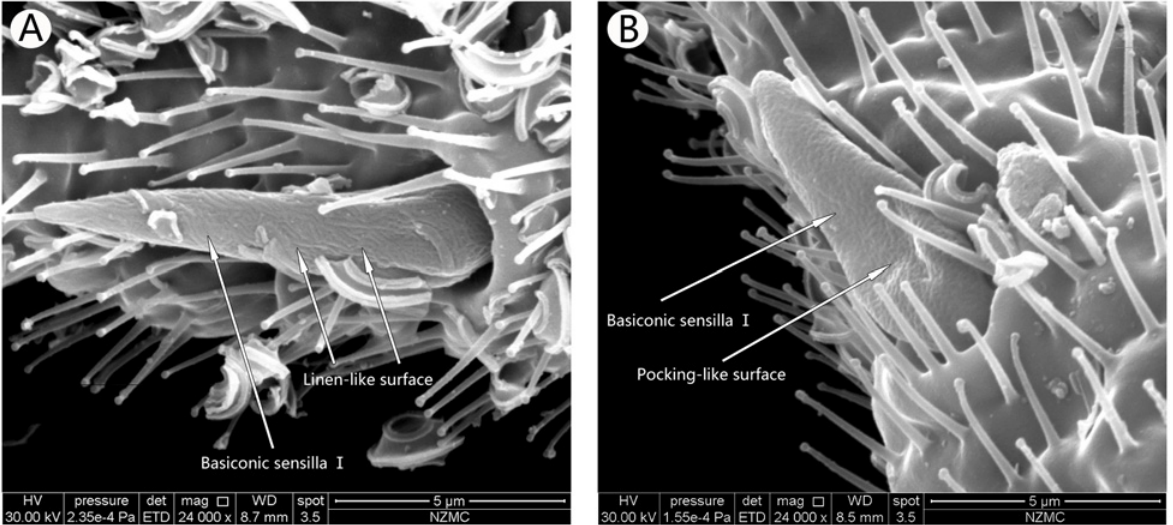
Fig 2. Ventral surface of the first flagellum showing the basiconic sensilla I in B . tabaci MEAM1 male (A) and MED female (B). Arrows indicate the surface Basiconic sensilla I. MEAM1 (A) has linen-like surface, while MED (B) has multiple pocking-like surface.